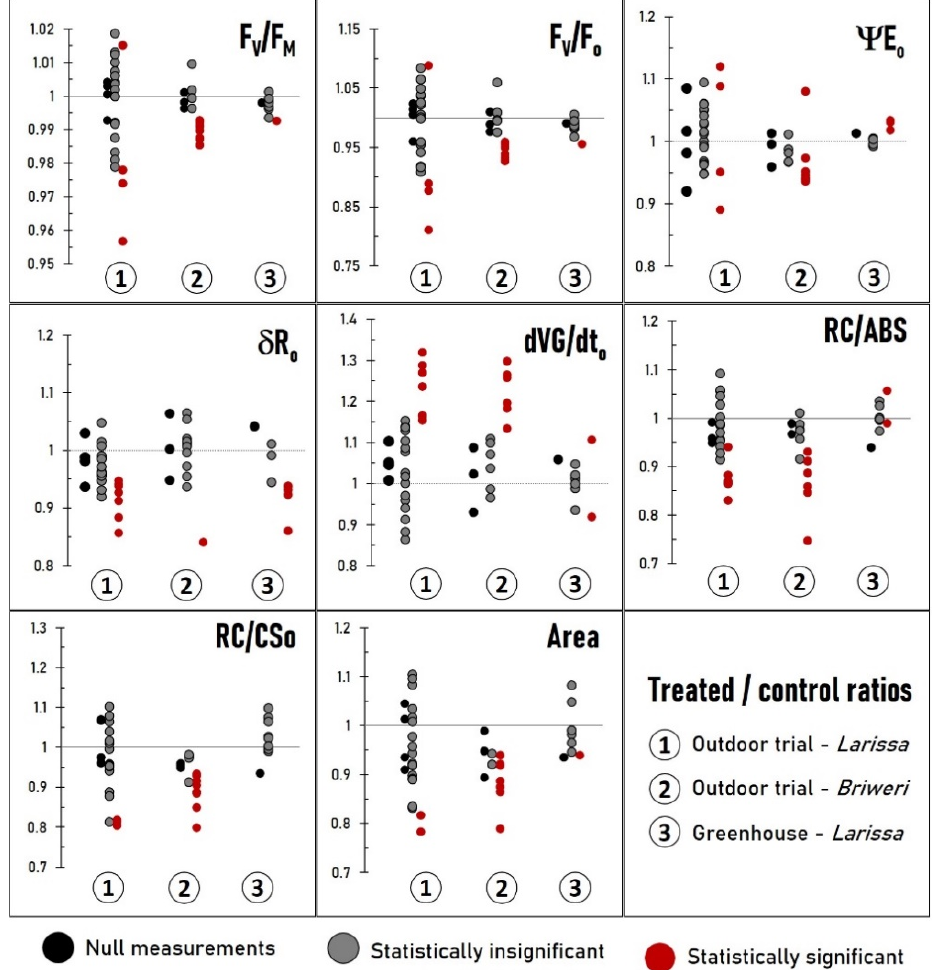
Figure 3. Distribution of treated/control ratios concerning the eight OJIP parameter under investigation: F V /F M —the maximal quantum yield of PSII photochemistry; F V /F O —the maximal quantum yield of oxygen-evolving complex (OEC); Ψ E O —quantum yield of the electron transport in the intersystem electron chain (from Q A to plastocyanin PC); δ R O —quantum yield of the reduction in end acceptors at PSI side; dVG/dt O —excitation energy transfer between the reaction centers; RC/ABS— effective antenna size; RC/CS O —reaction center density; area—pool size of reduced plastoquinone (PG) on the reducing side of PS II. The results are separated into three groups corresponding to outdoor trials with cultivar Larissa (1), outdoor trials with Briweri (2) and greenhouse experiment with Larissa (3). A dot symbolizes the treated/control ratio of each measurement point, in other words the difference between two groups at each measurement day: black—null measurements; gray—no statistically significant difference between treated and control groups ( p > 0.05); red—statistically significant difference from two groups ( p < 0.05). A treated/control ratio larger than one in case of dVG/dt O or less than one in case of all other parameters indicates lower photosynthetic efficiency in treated plants compared to control